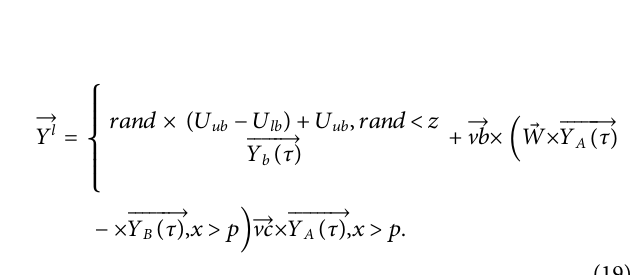
FIGURE 1 | Flow Chart of SMA